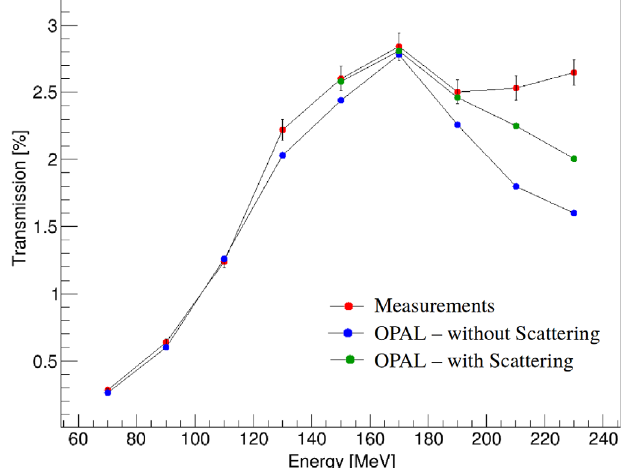
FIG. 12. Total transmission at the end of the beamline toward Gantry 3: comparison between the measurements and the OPAL model with and without the particle-matter interaction applied on the